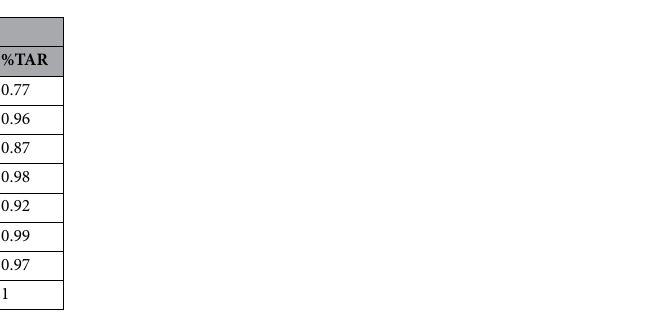
Table 2. TAR for the two enrollment ages and different finger fusions at the 0.1% FMR for 1, 2, 4, and 10 finger-fusion.